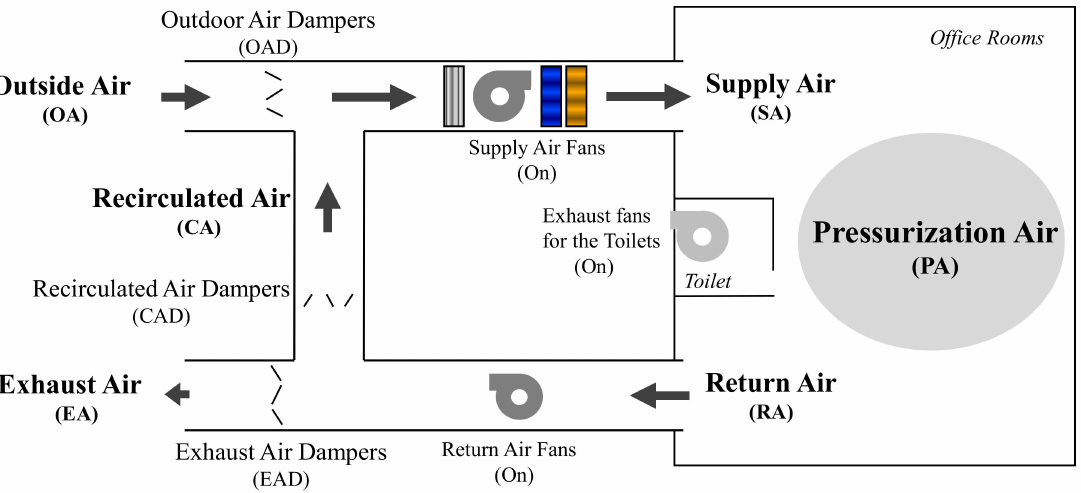
Figure 3. HVAC system settings when